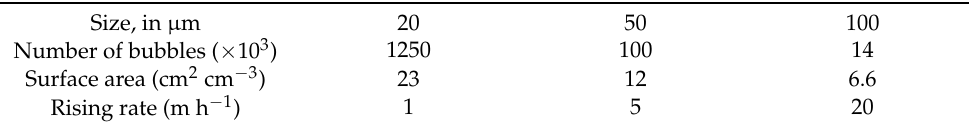
Table 1. The significance of bubbles size applied during